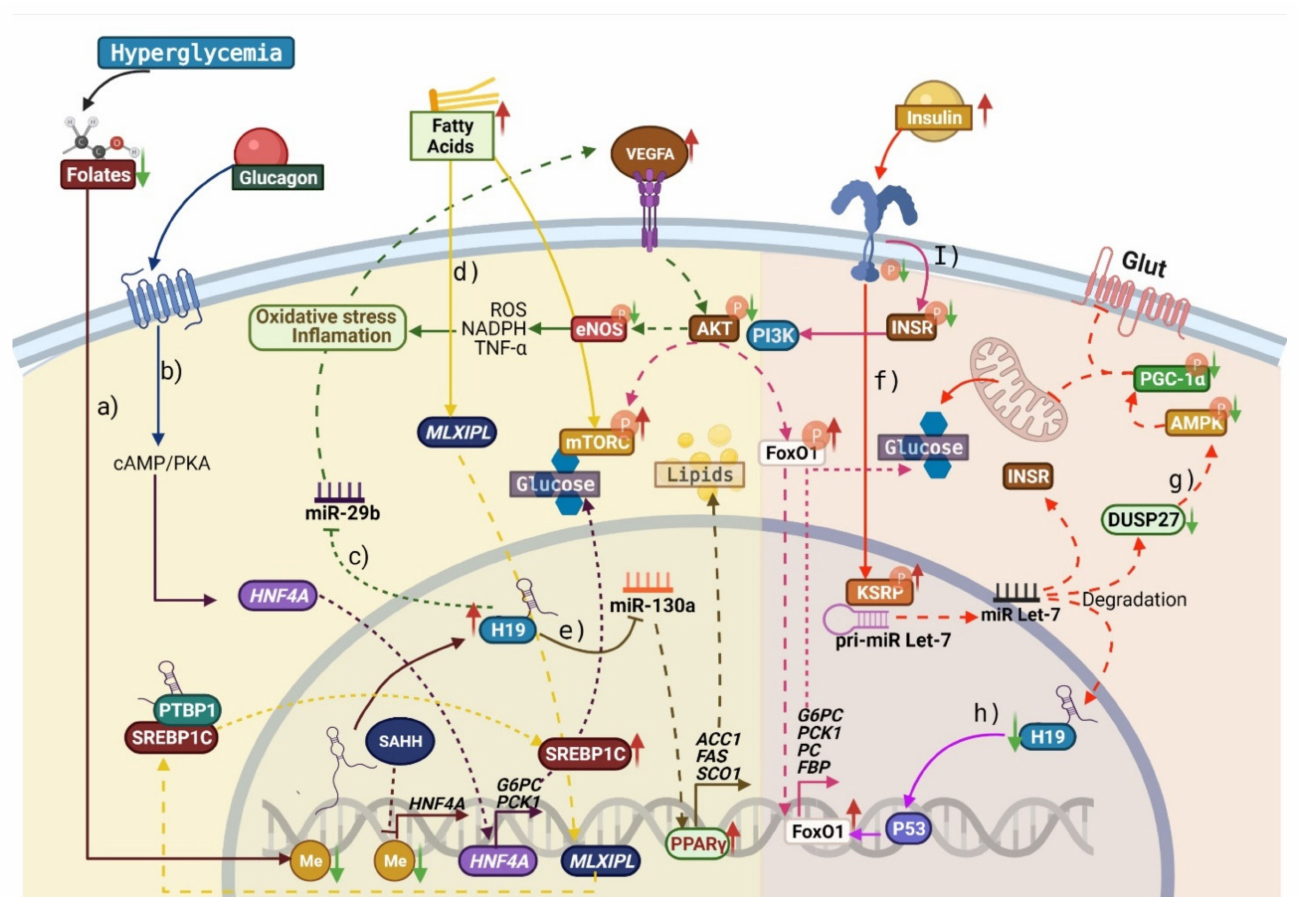
Figure 2. Imprinted maternally expressed transcript (H19) alterations and their molecular mechanisms. ( a ) The decrease in folates due to hyperglycemia leads to hypomethylation (Me) of the H19 promoter, increasing its transcription. H19 inactivates S-adenosylhomocysteine hydrolase (SAHH) and inhibits hepatocyte nuclear factor 4 alpha ( HNF4A ) promoter methylation. ( b ) The glucagon-stimulated upregulation of H19 via the cyclic adenosine monophosphate/ protein kinase A (cAMP/PKA) axis induces nuclear translocation of HNF4A and activates the transcription of gluconeogenic genes glucose-6-phosphatase catalytic ( G6PC ) and phosphoenolpyruvate carboxykinase ( PCK ). ( c ) Inhibition of miR-29b by H19 increases vascular endothelial growth factor-A (VEGFA) expression, leading to decreased activation of protein kinase B (AKT) and nitric oxide synthase (eNOS), increasing reactive oxygen species (ROS) production and proinflammatory cytokines. ( d ) High levels of free fatty acids (FFAs) promote H19 overexpression, which induces increased mTOR complex 1 (mTORC) signaling, nuclear translocation of MLX-interacting protein-like (MLXIPL) and element-binding transcription factor 1c (SREBP-1c), and the interaction of polypyrimidine tract-binding protein 1 (PTBP1) with SREBP-1c, which in turn induces lipid accumulation. ( e ) The binding of H19 to miR-130a induces the nuclear translocation of proliferator- activated receptor gamma (PPAR γ ), which activates the transcription of lipogenic genes such as acetyl-CoA carboxylase 1 (ACC1), fatty acid synthase (FAS), and cytochrome C oxidase (SCO1), promoting the intracellular accumulation of lipids. ( f ) Hyperinsulinemia induces the activation of far upstream element-binding protein (KSRP), which forms a complex with primiR Let7, promoting its maturation to miR-Let7, which binds H19, insulin receptor (INSR), and dual-specificity phosphatase 27 (DUSP27), degrading them. ( g ) The decrease in DUSP27 reduces the activation of cAMP-activated protein kinase (AMPK) and peroxisome proliferator-activated receptor gamma coactivator 1-alpha (PGC-1 α ), which inhibits glucose uptake and mitochondrial biogenesis. ( h ) H19 downregulation induces the binding of p53 to the forkhead box O1 ( FoxO1 ) promoter, increasing its transcription. ( I ) The insulin signaling pathway is deregulated, decreasing the phosphorylation of INSR and AKT by phosphatidylinositol 3-kinase (PI3K), which induces an increase in mTORC and FoxO1, promoting the translocation of FoxO1 to the nucleus and the transcription of gluconeogenic